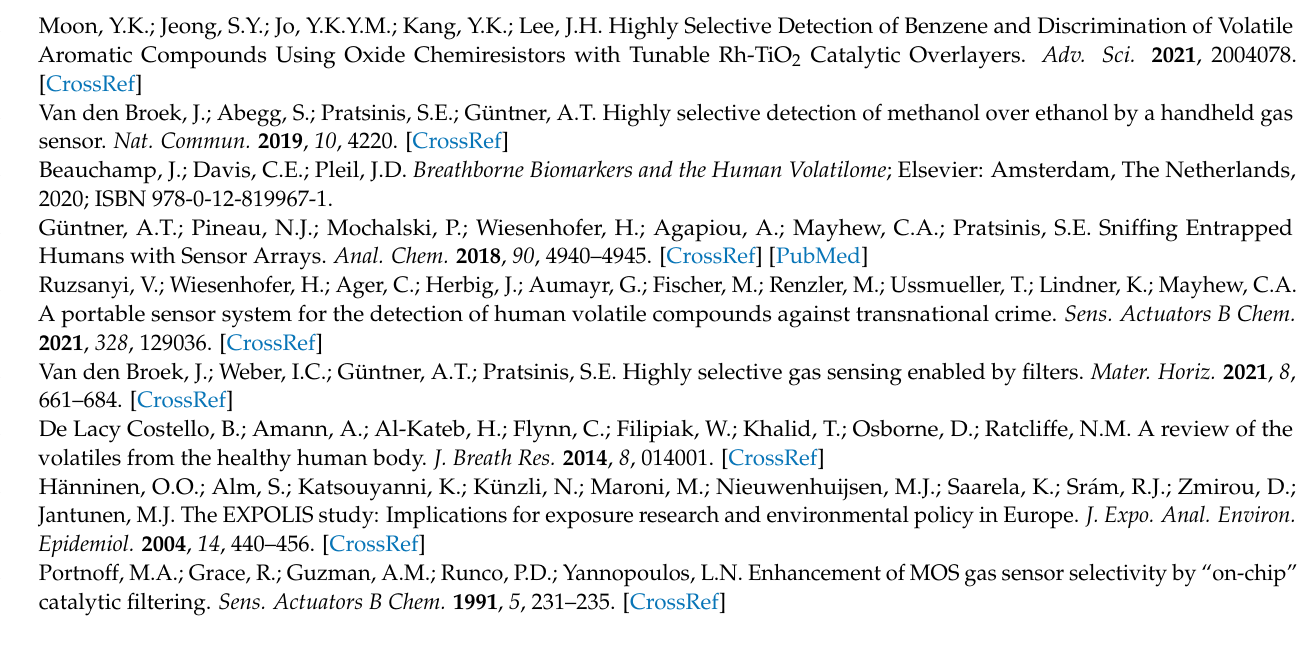
with NiO internal standard, Figure S3: STEM Pt cluster size determination, Figure S4: Particle size distributions, Figure S5: Catalytic performance before and after H 2 reduction, Figure S6: In situ XRD during H 2 reduction, Figure S7: Effect of relative humidity and flow. Figure S8: Filter performance with Pd/SnO 2